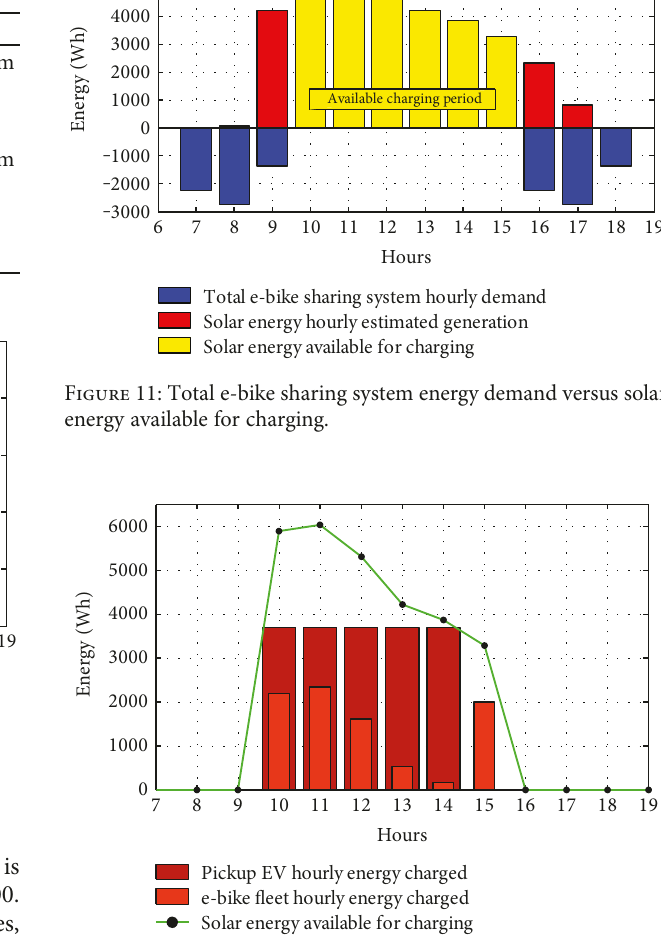
Figure 12: Charging process of the e-bike sharing